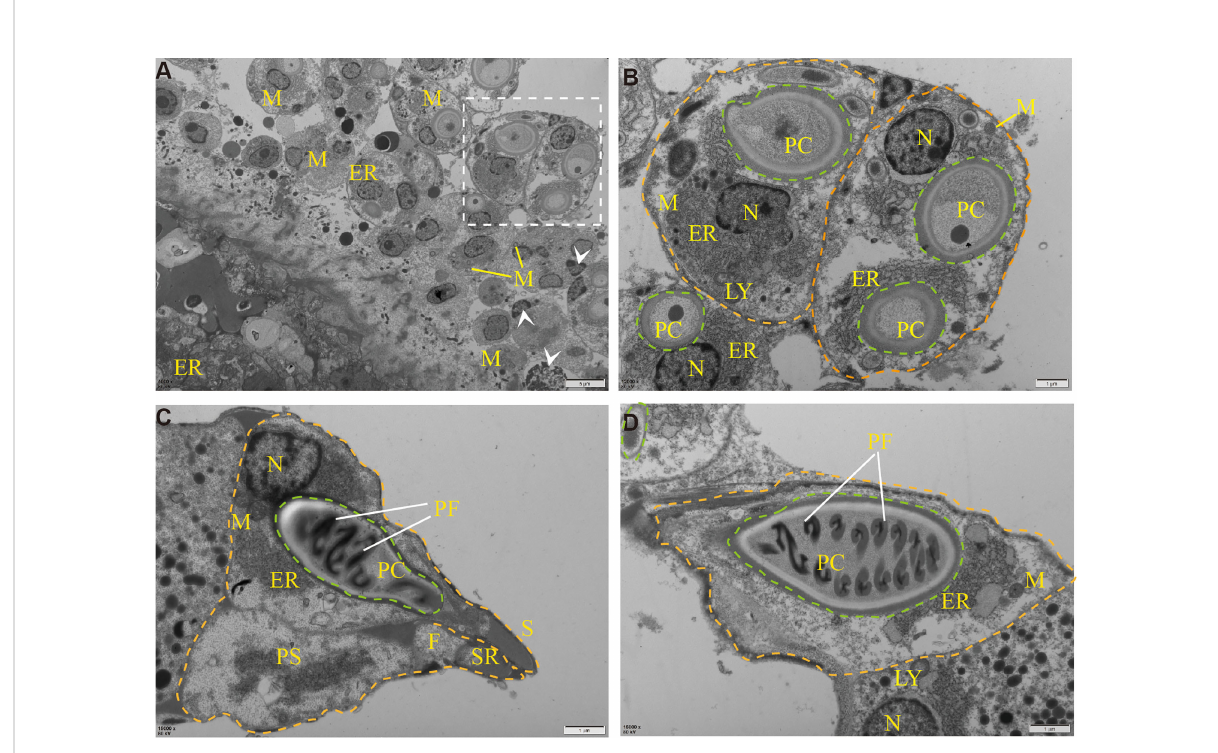
FIGURE 3 Transmission electron microscope observation of Myxobolus ampullicapsulatus . (A) Ultrapathological changes of gold fi sh infected with Myxobolus ampullicapsulatus , including mitochondrial and endoplasmic reticulum swelling, apoptosis (arrowhead), etc. (B) Partial enlargement of white dotted line. Transverse section of mature spore, each spore (orange dotted line) contained polar capsules at different stages (green dotted line) and was rich in organelles. (C, D) longitudinal section of the polar capsule: (C) The spore contained sporoplasm, a bottle-shaped polar capsule and was surrounded by a spore shell. (D) About 8 pairs of double “ S ” shaped polar fi laments were wound in the polar capsule. PC, polar capsule. PS, sporoplasm. PF, polar fi lament. N, nucleus. M, mitochondria. LY, lysosome. ER, endoplasmic reticulum. F, faveolate electron- dense object. SR, sutural ridges. S, scabbard. arrowhead, apoptotic cell. Orange dotted line: spore. Green dotted line: polar